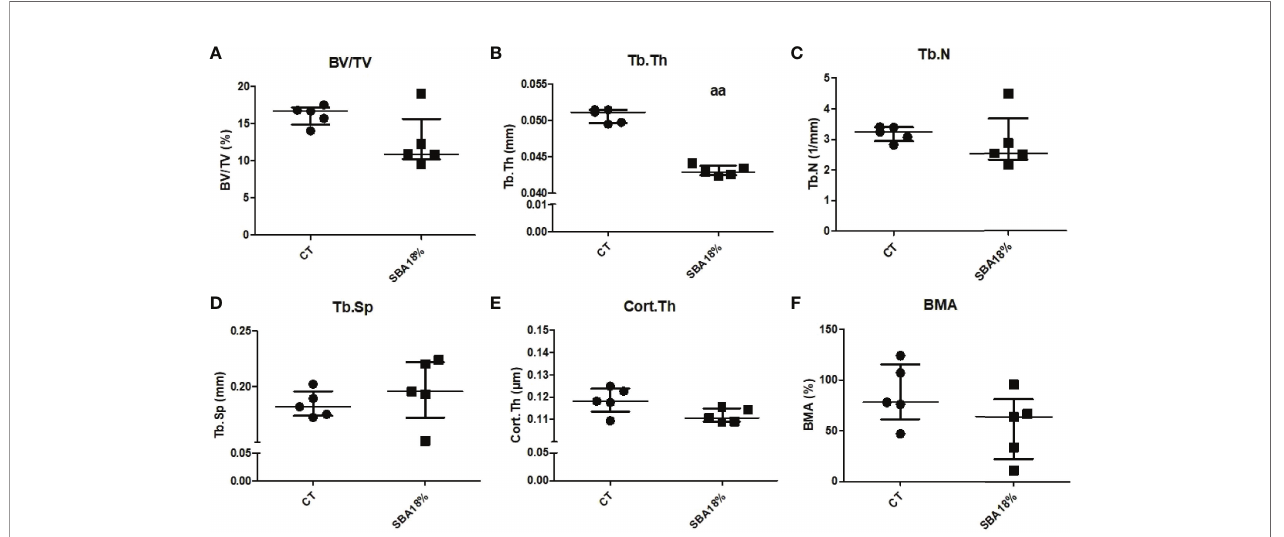
FIGURE 8 | The results of micro-CT analysis of tibia, showing different bone parameters after exposure to 4 weeks of SBA protocol. (A) Bone volume fraction (BV/TV) was expressed as a percentage on mineralized tissue in each condition after 4 weeks; (B-E) Trabecular thickness (Tb.Th), trabecular number (Tb.N) and trabecular spacing (Tb.Sp), and cortical thickness (Cort.Th), respectively, were evaluated for each animal and each condition after 4 weeks of SBA protocol (expressed in millimetres); (F) Bone marrow adiposity (BMA) was calculated as a percentage of BMAT in marrow volume. Data represent median and interquartile range; n = 5. Statistical analysis was performed using Mann – Whitney ’ s test. In C, aa - p < 0.005 when compared to CT